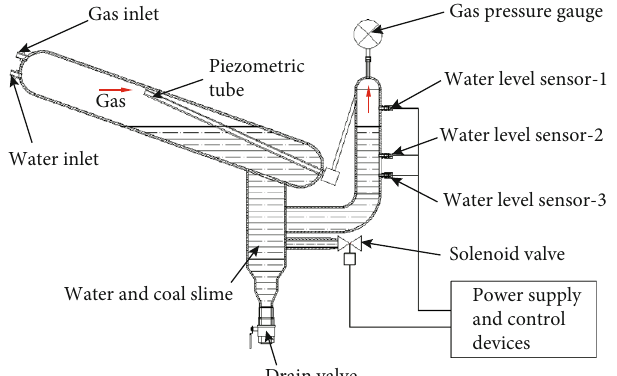
Figure 2: Schematic diagram of gas pressure measuring device for water-bearing coal seams.